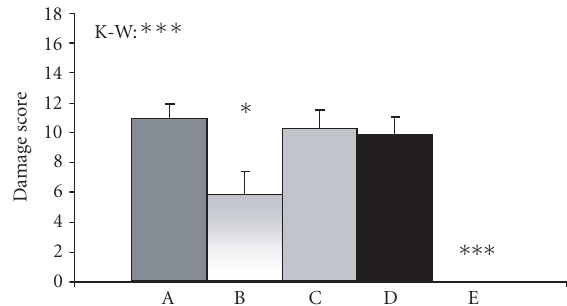
Figure 3: Colonic tissue damage. Macroscopic damage scores were assessed using Wallace’s colon macroscopic scoring system (31). Values are arithmetical means + SEM, n = 6 − 13. Statistical sig- nificance was assessed using the Kruskal-Wallis test (K-W, di ff er- ences between all groups of animals) and Mann-Whitney test (dif- ference between group D and other groups of animals). ∗ P ≤ . 05, ∗∗∗ P ≤ . 001. A, colitic animals fed with the combination of 0.4% thyme and 0.2% oregano oils; B, colitic animals fed with the com- bination of 0.2% thyme and 0.1% oregano oils; C, colitic animals fed with the combination of 0.1% thyme and 0.05% oregano oils; D, animals with TNBS-induced colitis; E, control sham animals.